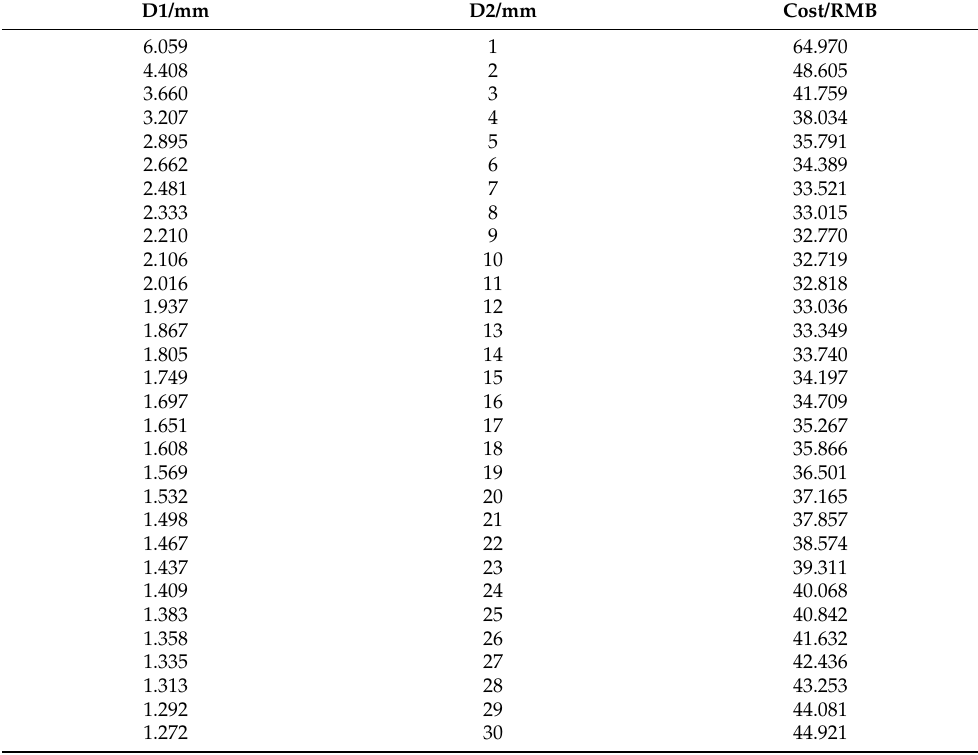
Table A1. Parameter Combinations and Cost Calculations Meeting the 22 dB (A) Sound